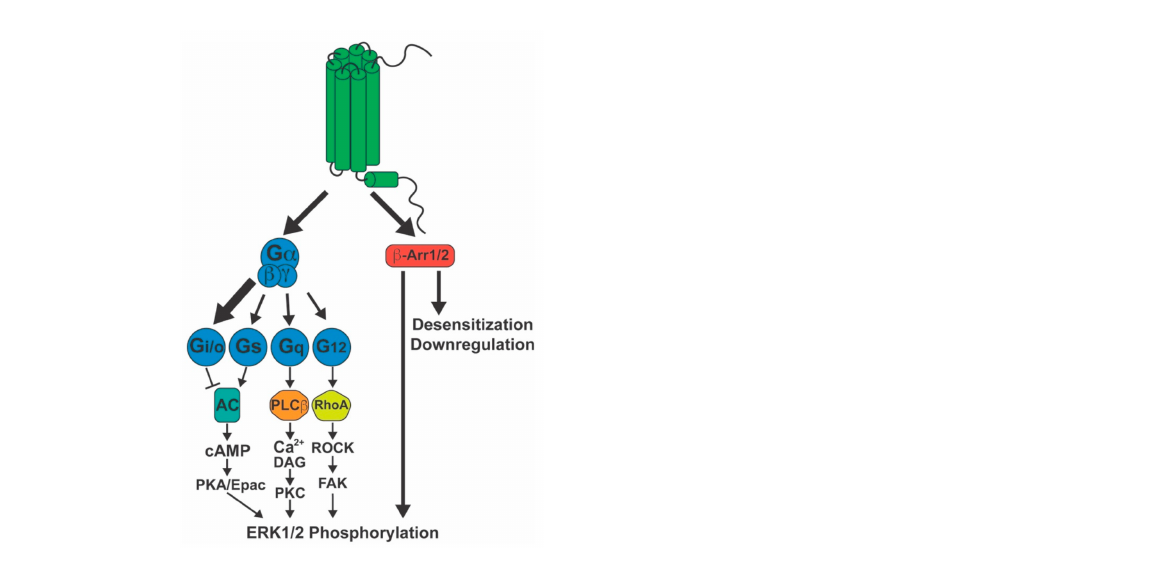
Figure 1. Signaling activated by the CB1 receptor. The CB1 receptor primarily couples to G i/o proteins (large arrow), but also to G s , G q/11, and G 12/13 (smaller arrows) to a lower extent. CB1 also recruits both β -arrestin1 and β -arrestin2. These proteins mediate receptor desensitization, endocytosis, and pERK1/2 signaling. The latter can also be induced by downstream signaling events stemming from the G-protein pathways. AC: adenylyl cyclase; β -Arr1/2: β -arrestin1/2; cAMP: cyclic adenosine monophosphate; DAG: diacylglycerol; Epac: exchange protein directly activated by cAMP; ERK1/2: extracellular-signal-regulated kinase 1 ; FAK: focal adhesion kinase; PKA: protein kinase A; PKC: 2 protein kinase C; ROCK: Rho-associated protein